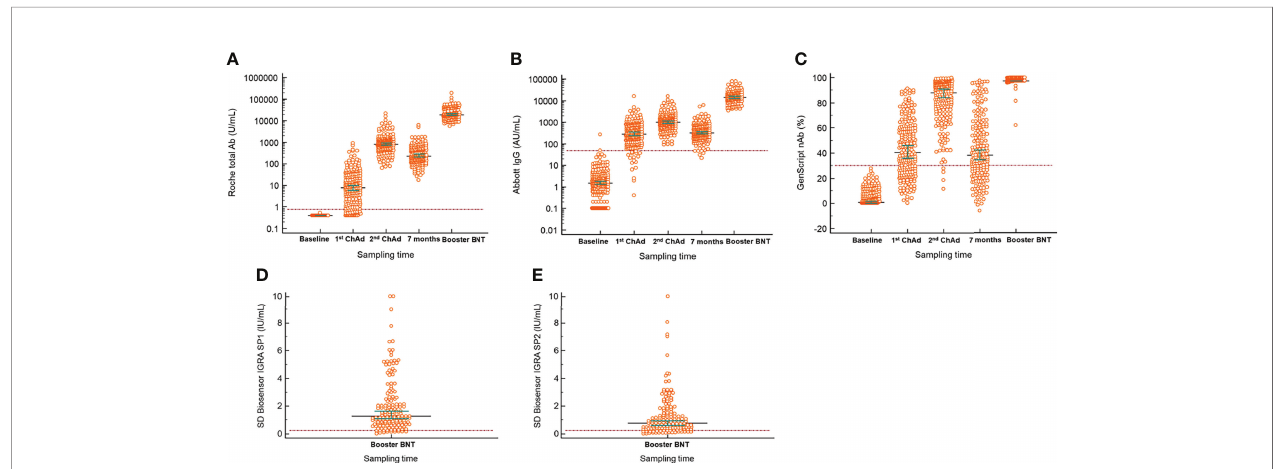
FIGURE 1 | Longitudinal serological responses to BNT162b vaccine as a booster after two complete doses of ChAdOx1 nCov-19. (A) Roche total antibody; (B) Abbott IgG; (C) GenScript neutralizing antibody; (D) SD Biosensor interferon-gamma release assay of Original spike protein (SP1) tube; (E) SD Biosensor interferon-gamma release assay of Variant spike protein (SP2) tube. The difference between the fi rst or second vaccination and booster injection in all included antibody assays was signi fi cant ( P < 0.001). Horizontal lines and whiskers indicate median and 95% con fi dence interval. The dotted lines indicate the cut-off values of the assays. ChAd, ChAdOx1 nCoV-19; BNT, BNT162b2; IGRA, interferon-gamma release assay.